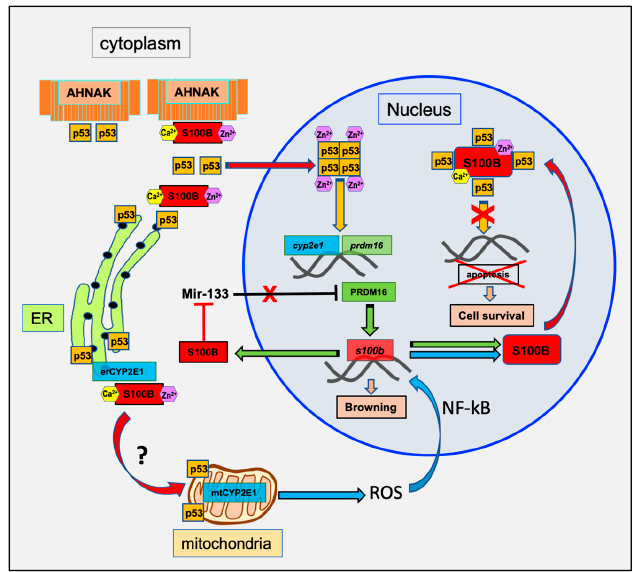
Figure 2. Schematic model of the transcriptional regulation of S100B for brown adipocyte di ff erentiation. Activation of brown adipocyte di ff erentiation triggers S100B transcriptional activation through ROS and PRDM16 pathways [15,28]. Increase in cytoplasmic S100B amplifies nuclear targeting of p53 and p53 transcriptional activation [38] and decreases miR-133 [28]. A negative regulation of p53 through cytoplasmic interaction with AHNAK is also suggested based on a study that characterized physical interactions between AHNAK and p53 and AHNAK-dependent inhibition of p53 nuclear activity [39]. Nuclear translocation of p53 further increases S100B expression level through synergistic transcriptional activation of both PRDM16 and CYP2E1-ROS pathways. Enhanced S100B expression results in S100B nuclear accumulation and down regulation of p53 transcriptional activity [20]. It is hypothesized that the nuclear S100B enhances survival of di ff erentiated BAT by inhibition of nuclear p53-dependant apoptosis [40]. A contribution of S100B to the mitochondria addressing of CYP2E1 and p53 is also suggested (see Section 3 for